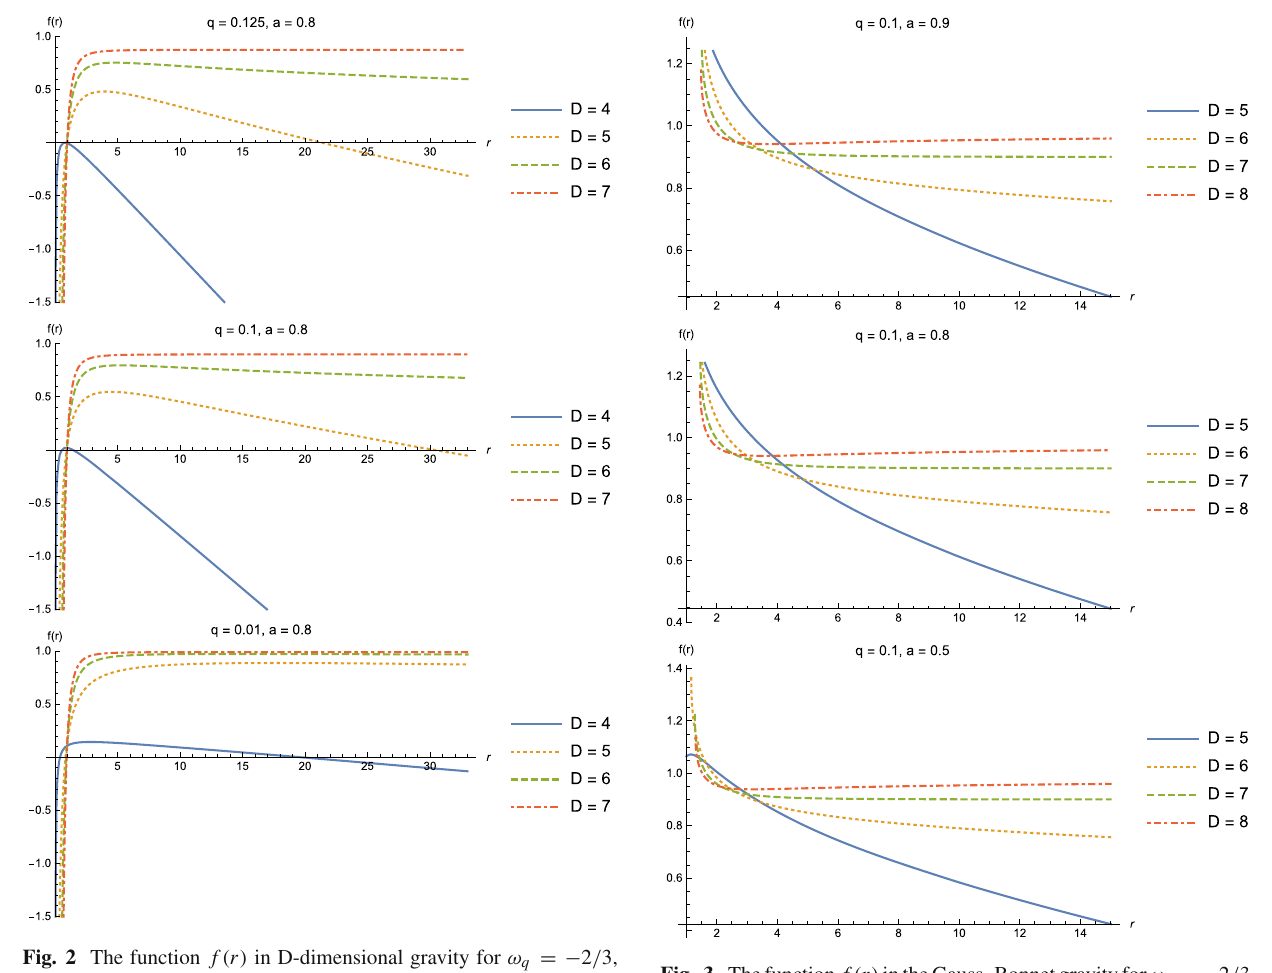
( r ) intheGauss–Bonnetgravityfor ω = − 2 / 3, q M = 1 and α 2 =